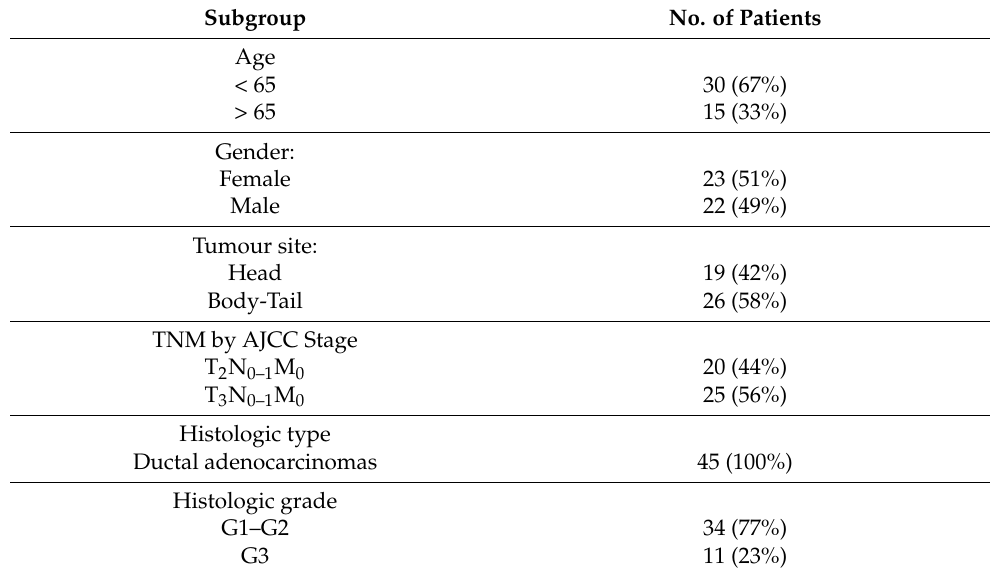
Table 1. Clinical–pathological features of patients ( n =